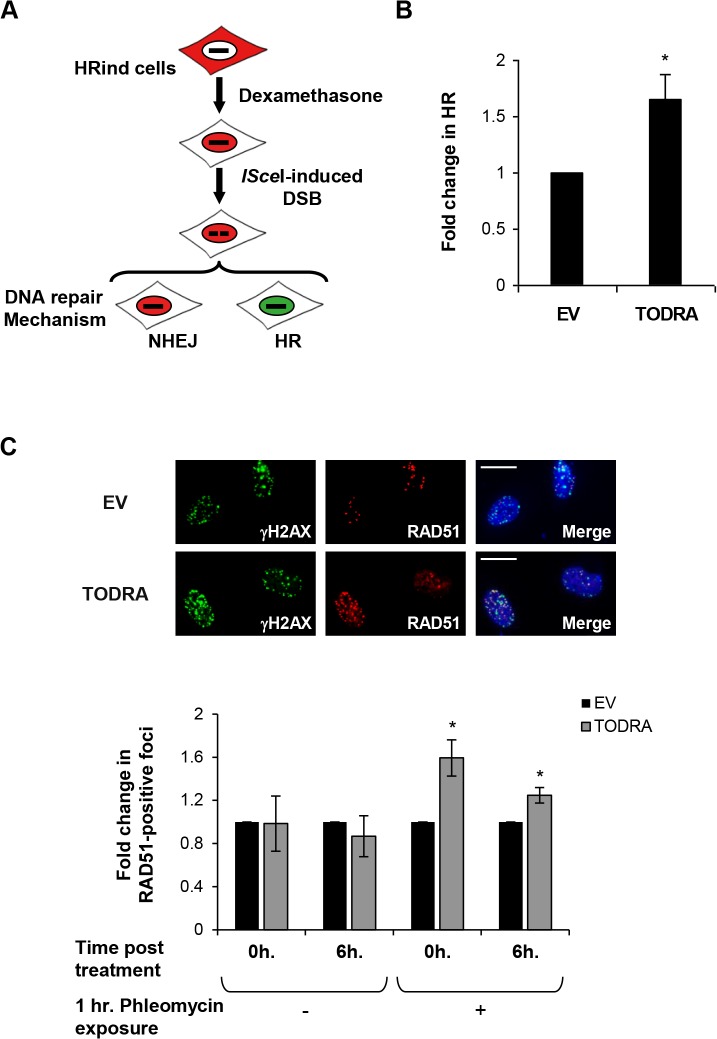

TODRA promotes homologous recombination repair of DSBs.
A.
Schematic representation of the HRind cell system
. The mCherry-ISceI-GR (Glucoroticoid Receptor) endonuclease is cytoplasmic. Upon addition of Dexamethasone, it rapidly translocates into the nucleus generating a DSB at the ISceI site in the DR-GFP cassette. The DSB can be repaired either by NHEJ (non-homologous end-joining) or HR, but only HR repair reconstitutes functional GFP (green nucleus) from DR-GFP. B.
Overexpression of TODRA induces RAD51-dependent HR. HRind cells were transfected with an empty vector (EV) or TODRA minigene and induced with Dexamethasone for 48 hours. GFP expression was measured by FACS. Results are depicted as the fold change in observed HR (as indicated by the number of GFP-positive cells) compared to the empty vector. Values are means ± SE of 3 independent experiments performed in triplicate. * p< 0.04. C.
Overepxression of TODRA elevates DNA damage-induced RAD51 foci formation. U2OS cells were transfected with an empty vector (EV) or the TODRA minigene. 48 hrs. post transfection half of each culture was treated for 1 hr. with the DNA damaging agent phleomycin (10μg/ml). Medium was then replaced in all cultures, releasing treated cells from phleomycin exposure. γH2AX and RAD51 foci were imaged either immediately (0 hours) or 6 hours after removal of phleomycin and medium exchange. Top: A representative image of γH2AX (green) and RAD51 (red) foci in empty vector (EV) and TODRA transfected cells 6 hours after removal of phleomycin. DAPI (blue signal in merged images) was used for counterstaining. Scale bars = 10 μm. Bottom: The number of RAD51-positive foci was normalized as the fraction of γH2AX-positive foci per cell and averaged across all samples in each condition. Cells were treated with phleomycin, as indicated, and fixed at the indicated time points post-treatment. Results are depicted as the fold change in the fraction of RAD51 foci in cells overexpressing TODRA compared to the empty vector. Values are means ± SE of 3 independent experiments. * p≤ 0.03.